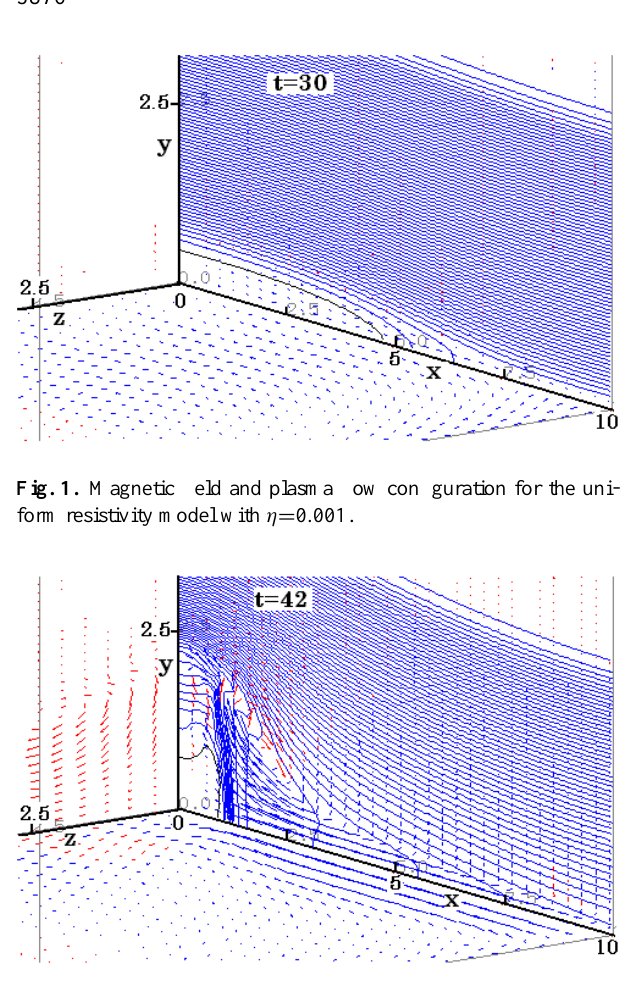
Fig. 2. Magnetic field and plasma flow configuration for the anoma- lous resistivity model (Eq. 4) with V C = 12, where the velocity scale is the same as in Fig. 1.